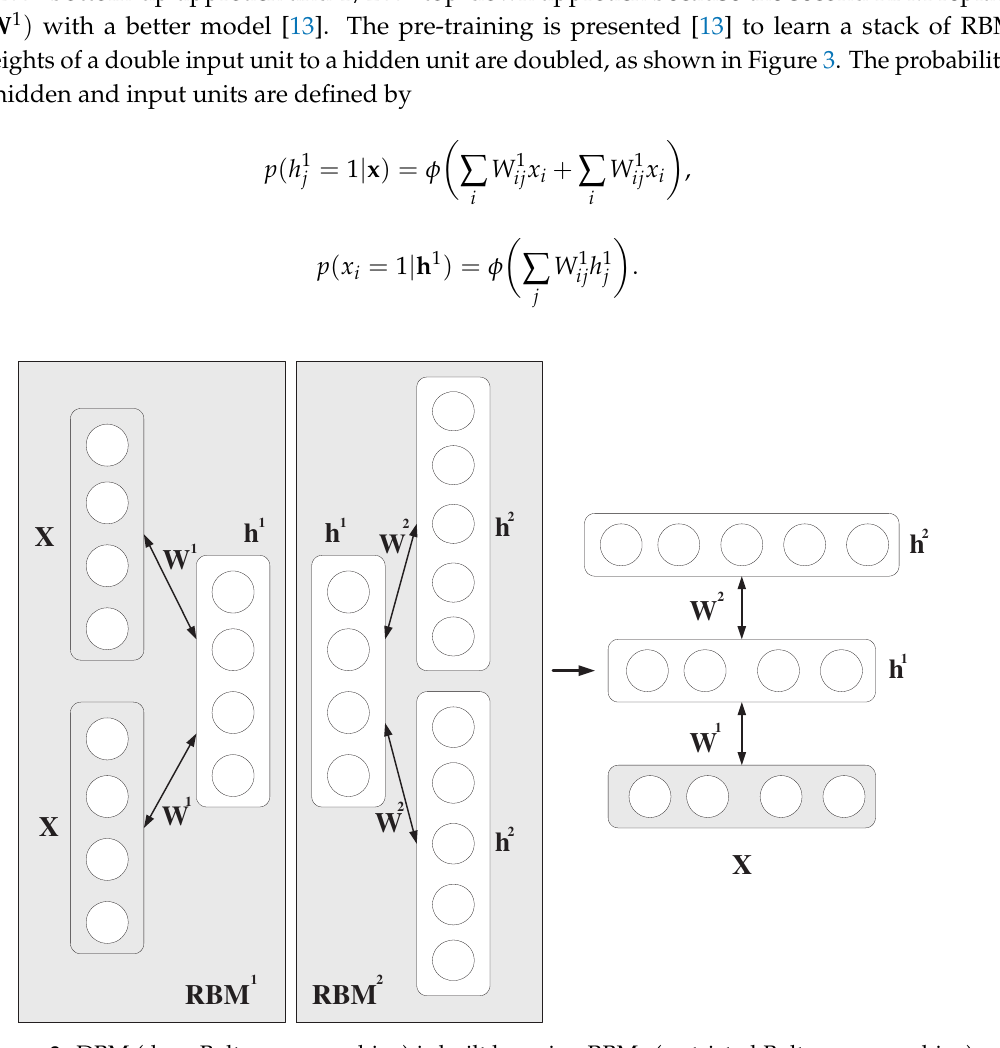
Figure 3. DBM (deep Boltzmann machine) is built by using RBMs (restricted Boltzmann machine), where W is a weighted parameter